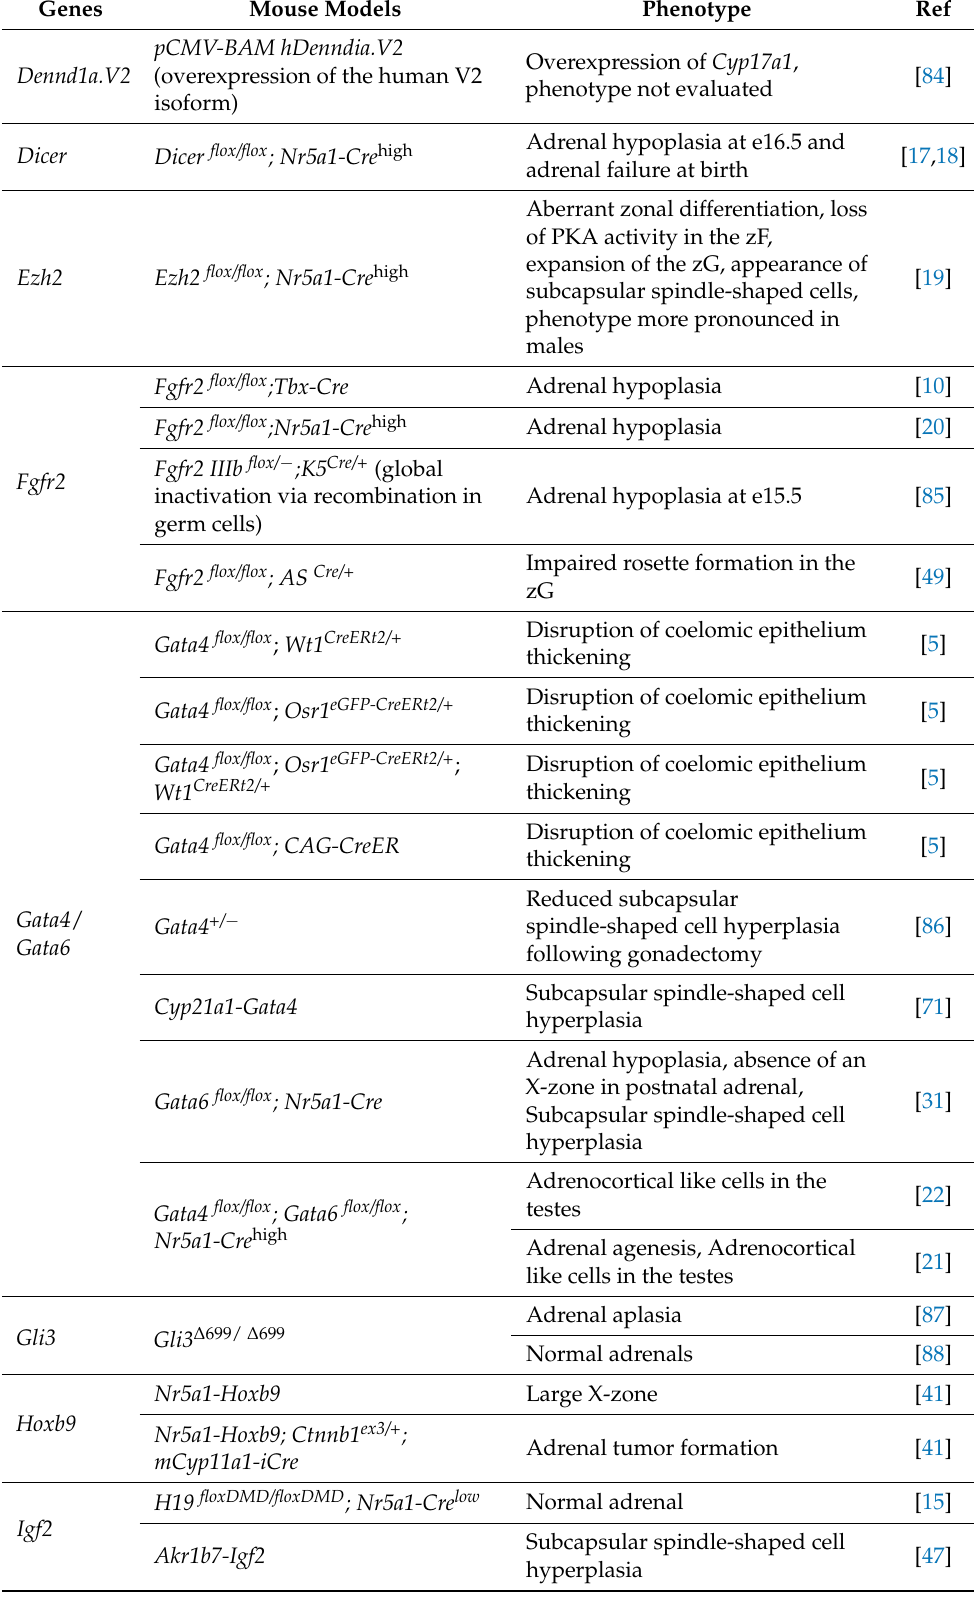
Table 2. Cont. Genes Mouse